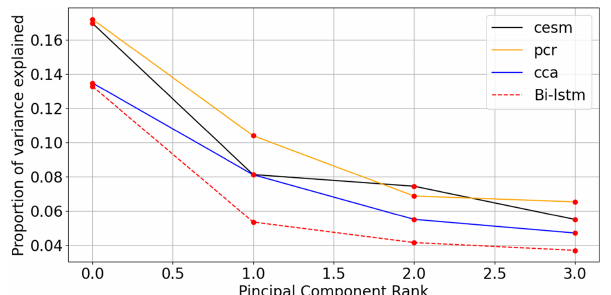
Figure 9. Eigenvalue spectra for the CESM simulation and three method reconstructions: the spectra for the CESM simulation and three method-based ideal PPEs are computed as the ratio between each of the first four reconstructed eigenvalues and the cumulative sum of all eigenvalues from the target CESM